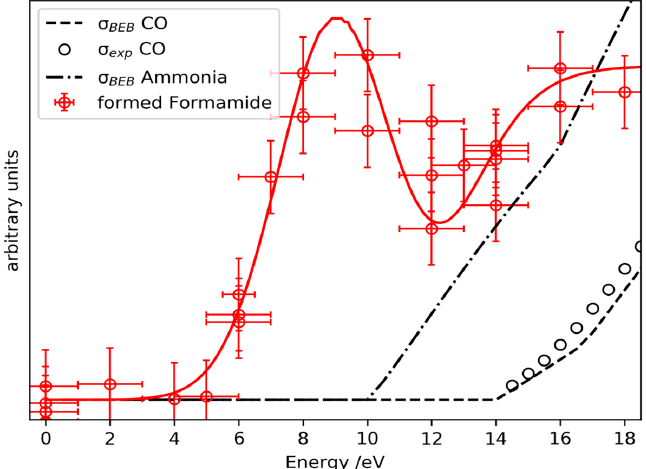
Figure 2. Predicted (black lines) electron impact cross-sections for carbon monoxide and ammonia. Experimental cross-sections for carbon monoxide (black open circles) are taken from Rapp and Englander-Golden [10]. The amount of formamide actually formed by electron irradiation of a 1:1 mixture of ammonia and carbon monoxide is shown in red circles. The red line only serves as a guide to the eye. Experimental data taken from Bredehöft et al. [20].